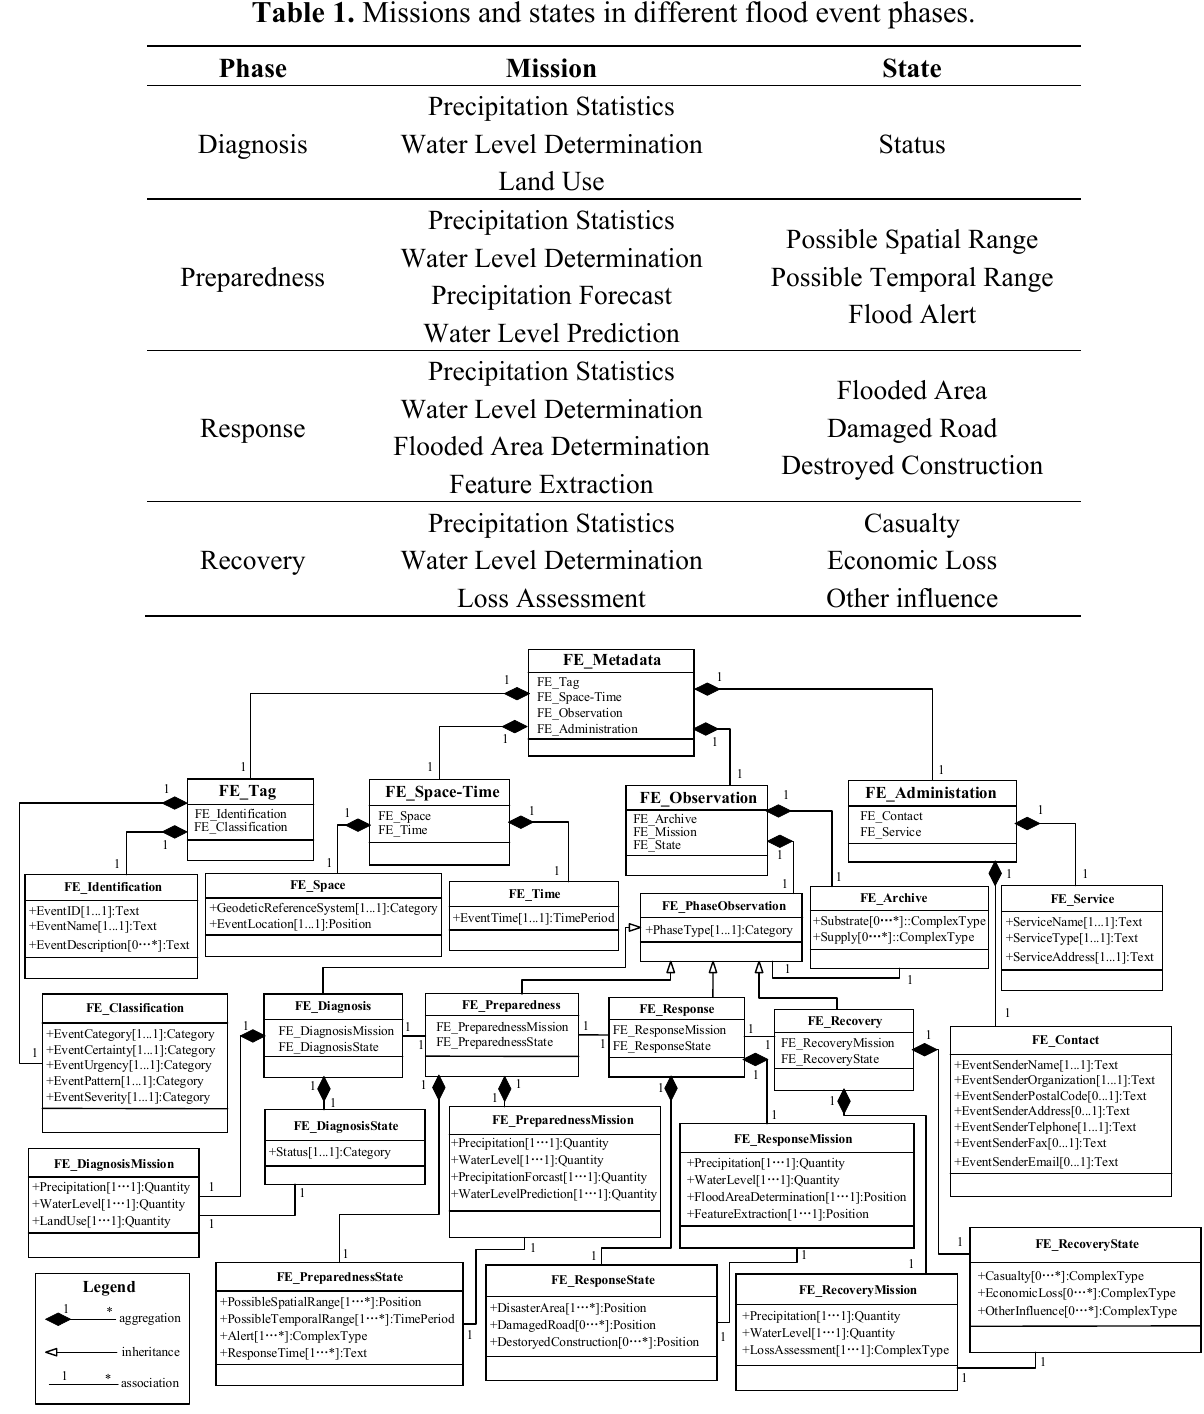
Figure 6. Unified modeling language (UML) diagram of FLCNDEM for floods. FE here means flood